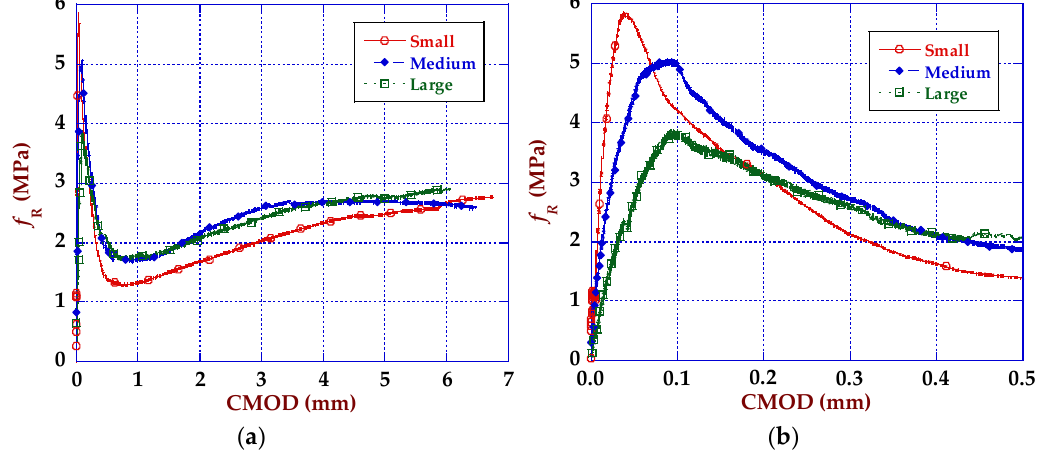
Figure 9. Residual strength-CMOD curves: ( a ) complete test; ( b ) for a notch tip opening up to 0.5 mm.